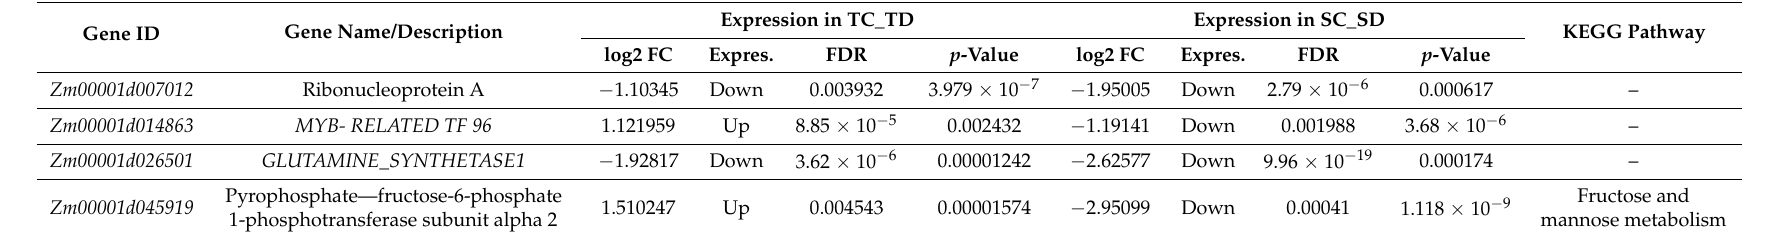
Table 6. Common DEGs between lines (YE8112 and MO17) after drought